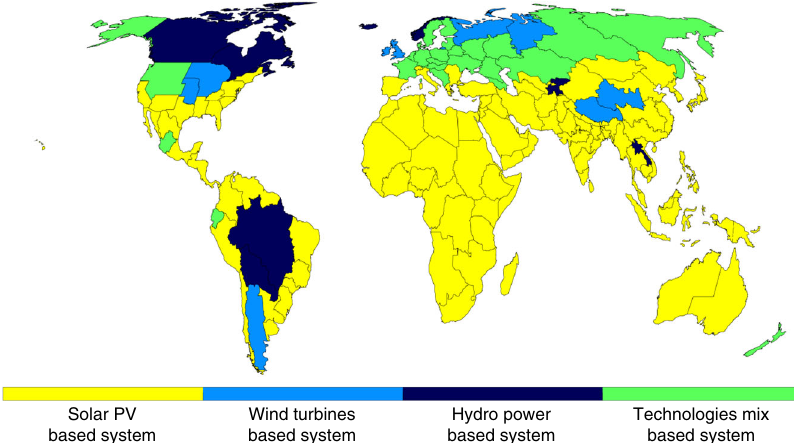
Fig. 1 Main types of 100% renewable electricity systems. Four main types of RE-based power systems are identi fi ed based on their main source of electricity (more than 50% share of electricity generation). If none of the technologies have a share exceeding 50%, then the type is de fi ned as “